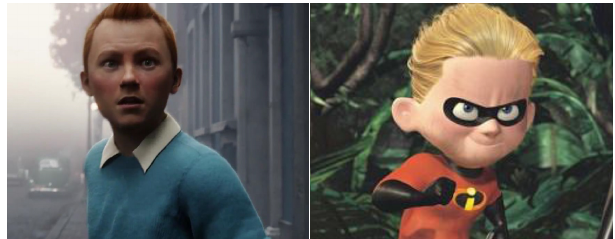
Figure 1. Two characters showing different levels of stylization: realistic (left) [14]; stylized (right)